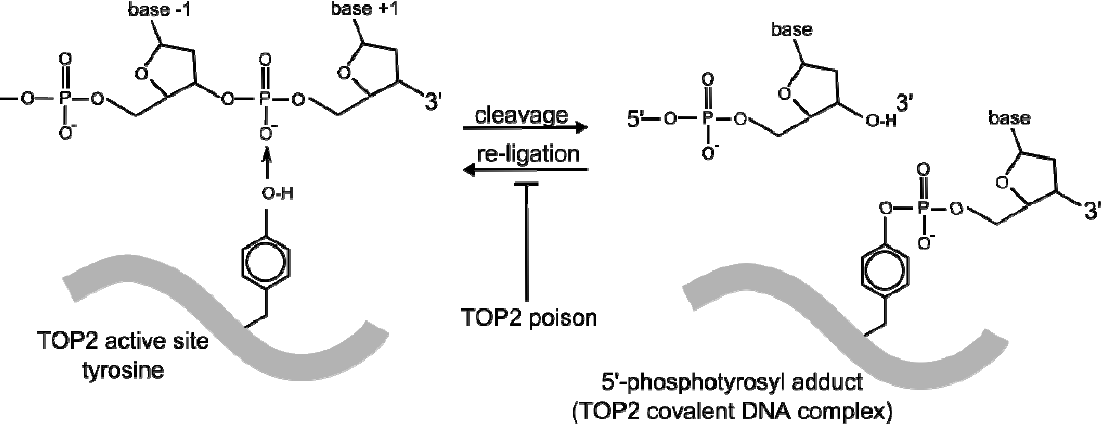
Figure 2. TOP2 DNA cleavage. TOP2-catalyzed strand cleavage involves a reversible, covalent enzyme–DNA adduct formed through the TOP2 active site tyrosine residue. Topoisomerase poisons inhibit the reverse reaction (re-ligation) resulting in stabilization of the 5’ phosphotyrosyl-DNA complex (cleavage complex) which contains a TOP2-linked strand breaks. The TOP2 protein molecule is represented by the thick grey line. Only one TOP2 monomer and one strand of the DNA duplex are shown.